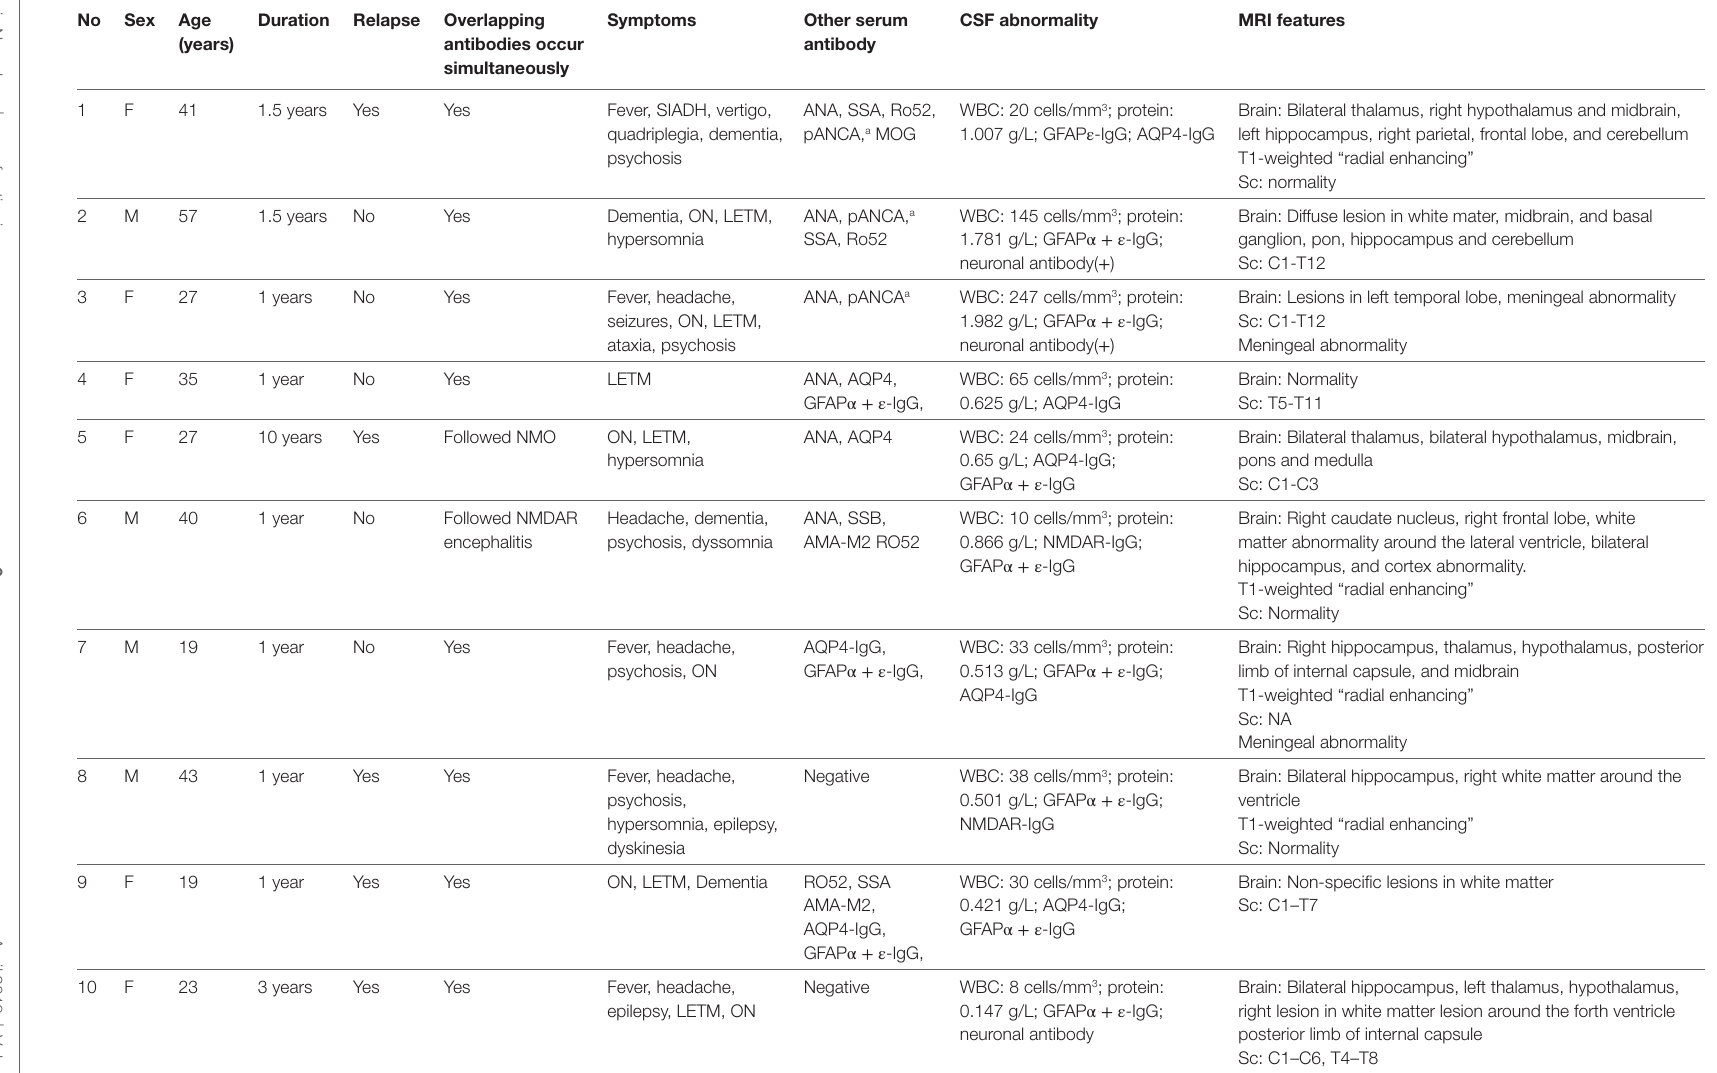
TaBle 1 | Data of 10 patients with autoimmune overlapping